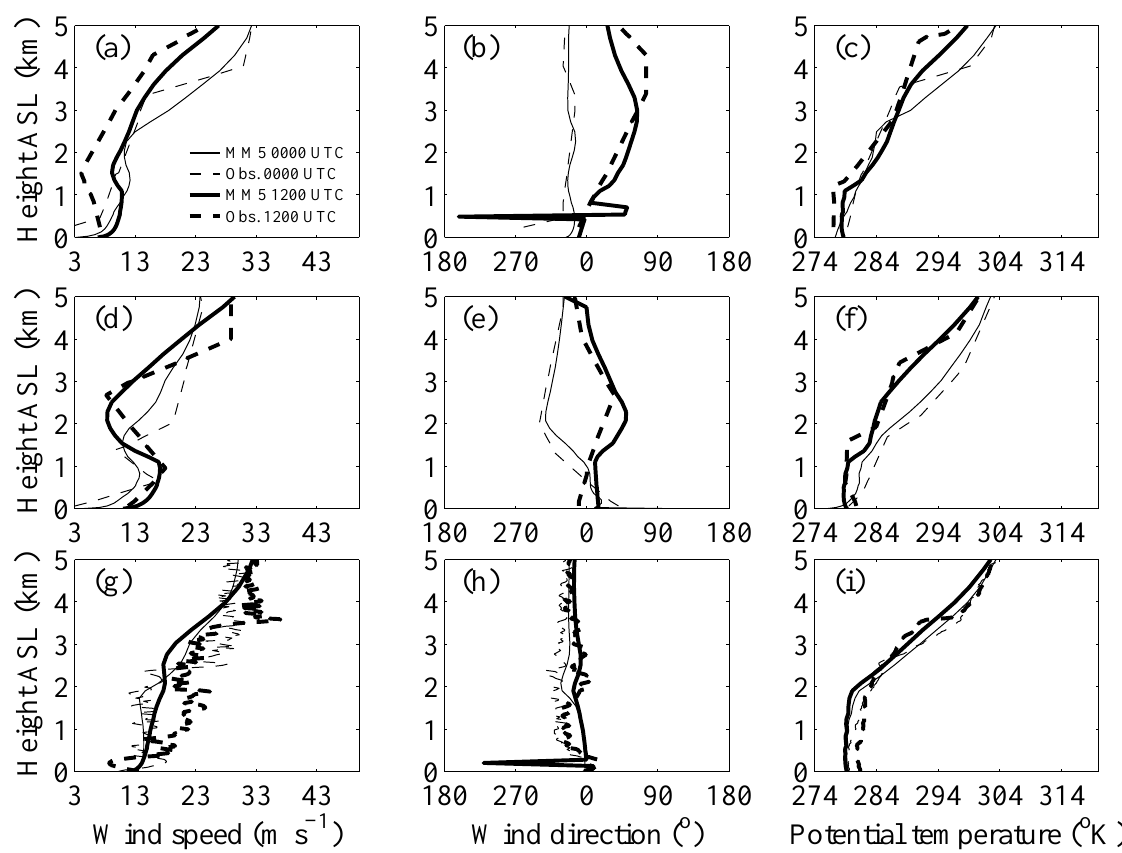
Fig. 3. Vertical profiles of wind speed, wind direction and potential temperature (left, middle and right columns, respectively) over Lyon, Nˆımes and on the location of the R/V ATALANTE (top, middle and bottom rows, respectively). The measured and simulated profiles are displayed with dashed and solid lines, respectively. On the first and the second rows, thin lines represent measurements at 0000 UTC and bold lines represent measurements at 1200 UTC. On the third row, thin lines are for measurements at 0900 UTC and bold lines are for measure- ments at 1100 UTC. The location of the R/V ATALANTE was 42.75 ◦ N/4.37 ◦ E at 0900 UTC and 42.95 ◦ N/4.27 ◦ E at 1100 UTC.